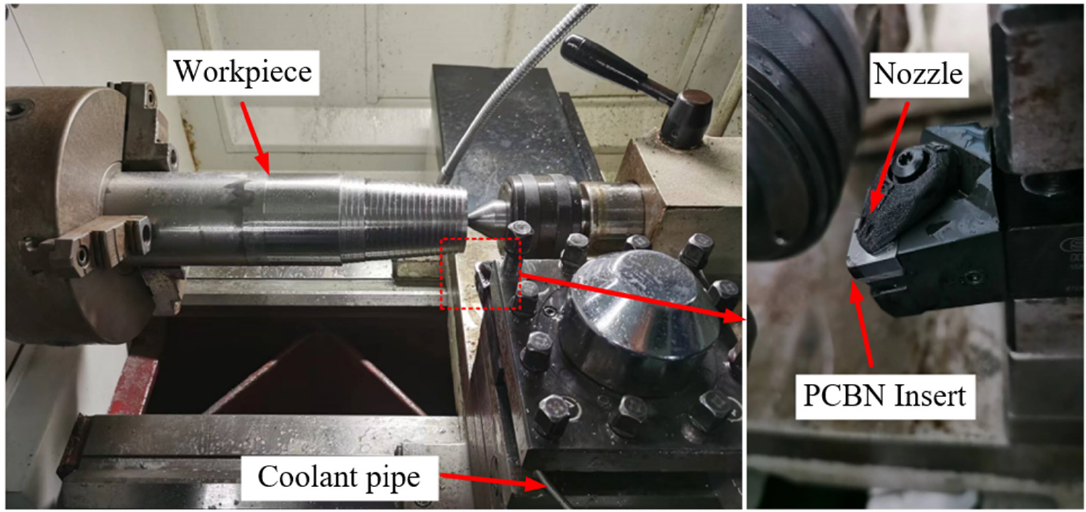
Figure 9. Experimental device for cutting GH4169 under high-pressure cooling.